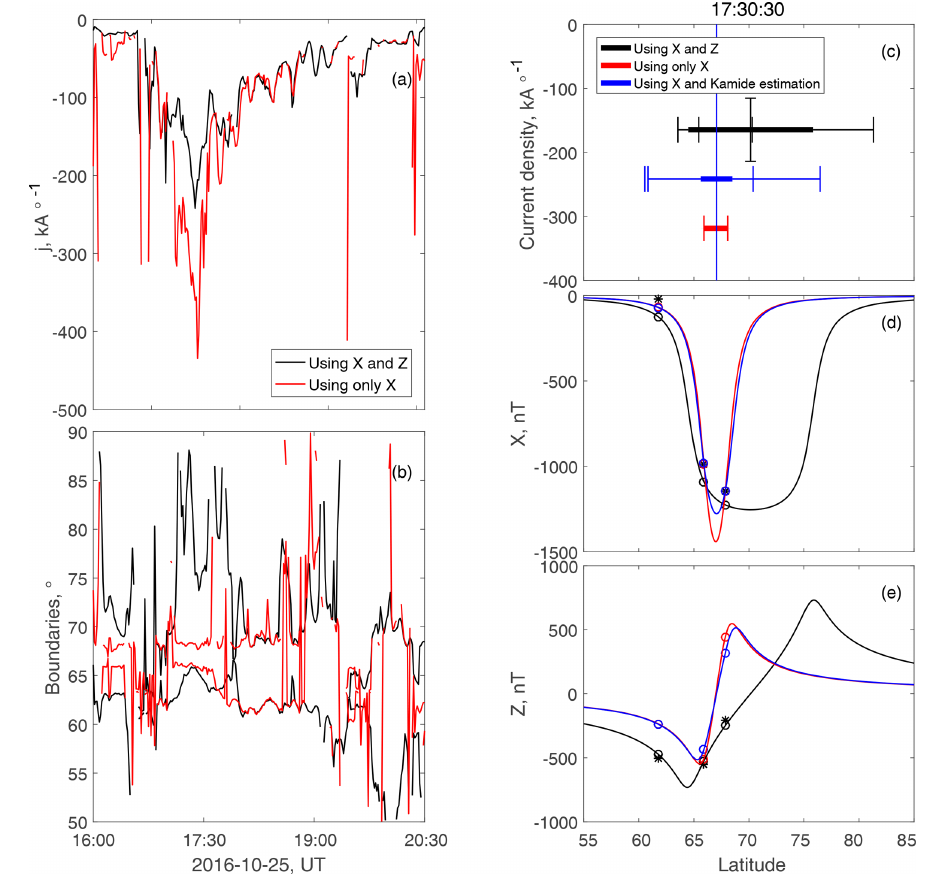
Figure 8. Variants of Model 3 for Example 2. Panels (a, b) show the model current density and the electrojet boundaries (black shows the full Model 3 with X and Z inputs, and red shows the reduced Model 3 with only the X input). Panels (c, d, e) show the latitude cut for 17:30:30UT for the two model variants and also for a variant with the current density fixed using the estimate from Kamide et al. (1982). The measured field is shown using black stars, and the model field and current are shown using lines. The error bars in panel (c) show the standard